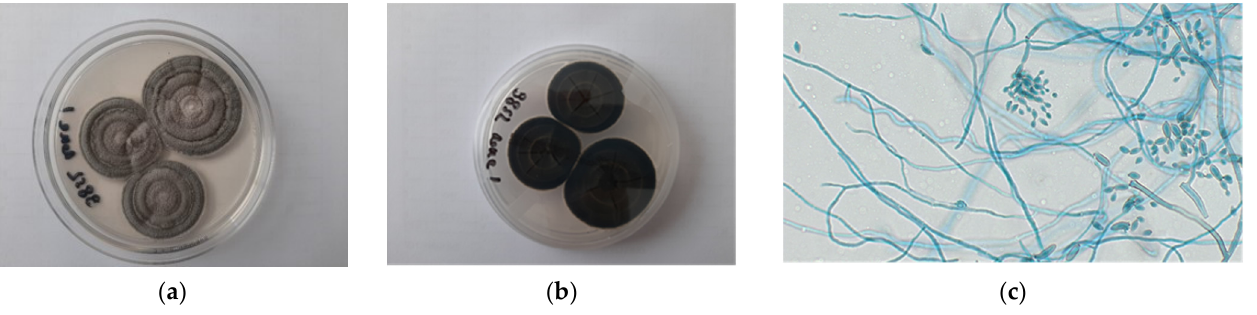
Figure 7. C. allicinum culture, macroscopic olive black filamentous colonies, right ( a ); and reverse ( b ), after 7 days of incubation at 25 °C on Sabouraud Dextrose and microscopic observation in lactophenol: septate hyphae and numerous and branched acropetal chains conidia ×40 ( c ).